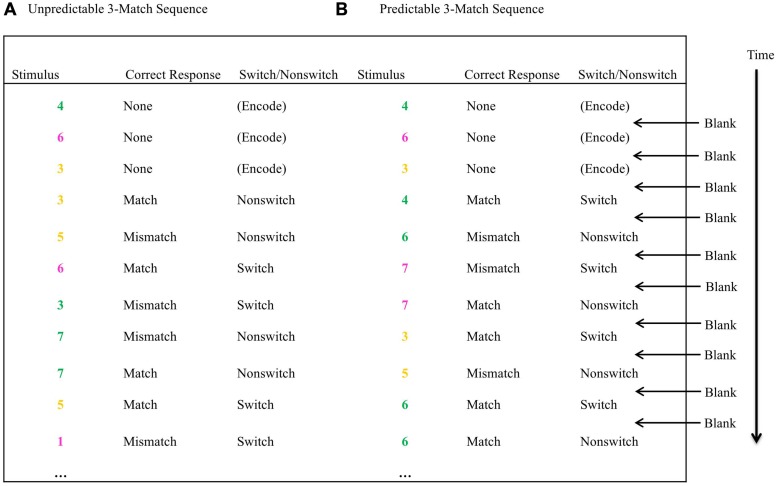
Illustration of a three-Match trial run: (A) Unpredictable, where digits appeared in a random color sequence, (B) Predictable, where the digits appeared in the same color for two consecutive trials. The first three trials were “encoding only” trials where no response was required, because there were no prior trials to compare with. The subsequent trials required responses. “Blank” represents a black screen presented for 300 ms to allow for distinction between two consecutively presented same-colored digits of equal identities.